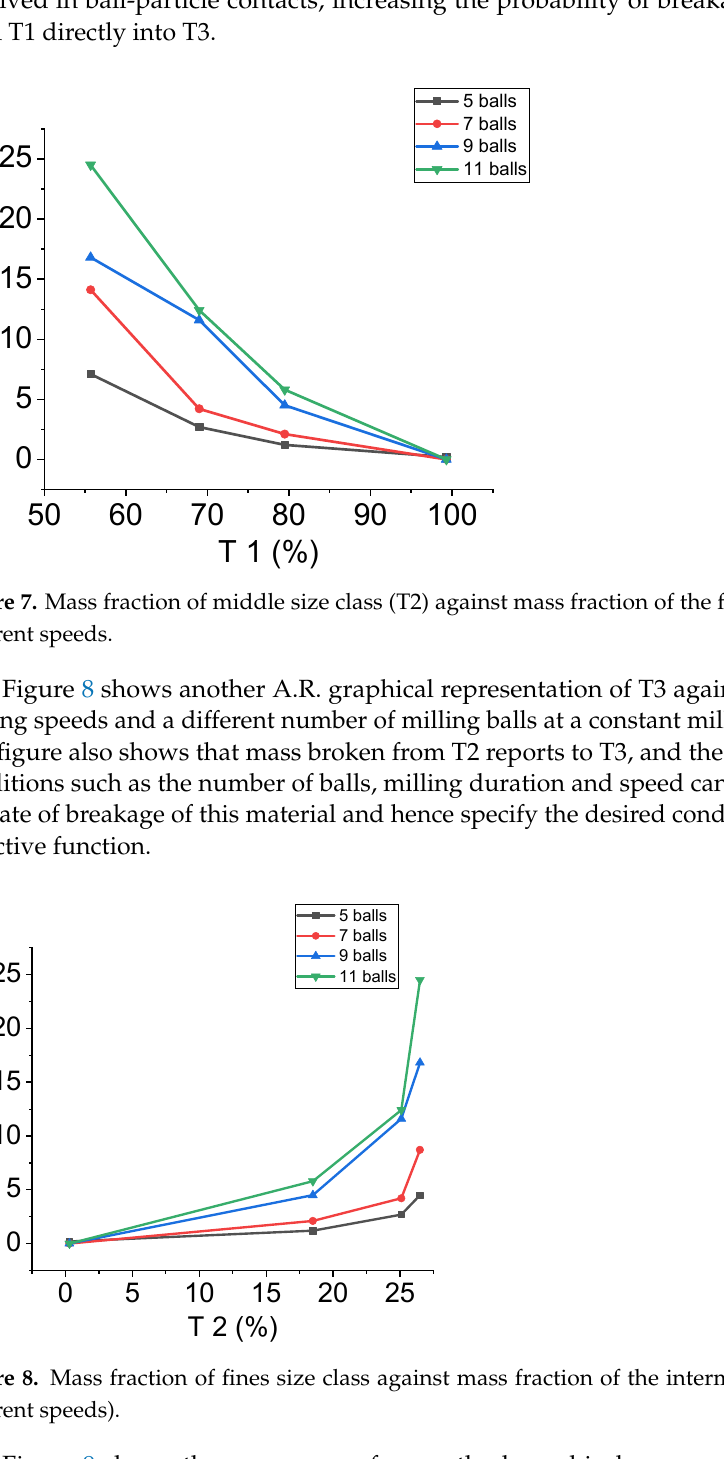
Figure 6. Mass fraction of middle size class (T2) against the mass fraction of the feed (T1) of the sample for different speeds.